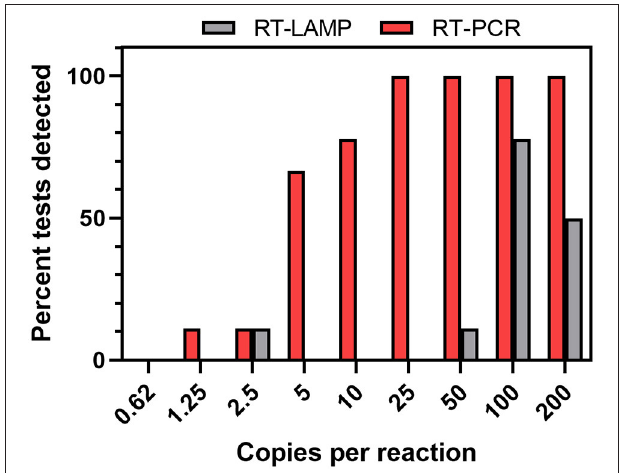
FIGURE 5 | RT-PCR and RT-LAMP comparison using synthetic standards. Dilutions of synthetic control RNA in water were extracted and assayed ( n = 4 or 9 tests per dilution). For RT-PCR assays, the viral genes were considered detected if 2 of the 3 viral genes were detected. TABLE 2 | Positive SARS-CoV-2 samples and associated Ct values from the RT-PCR assay. S gene N gene ORF1ab